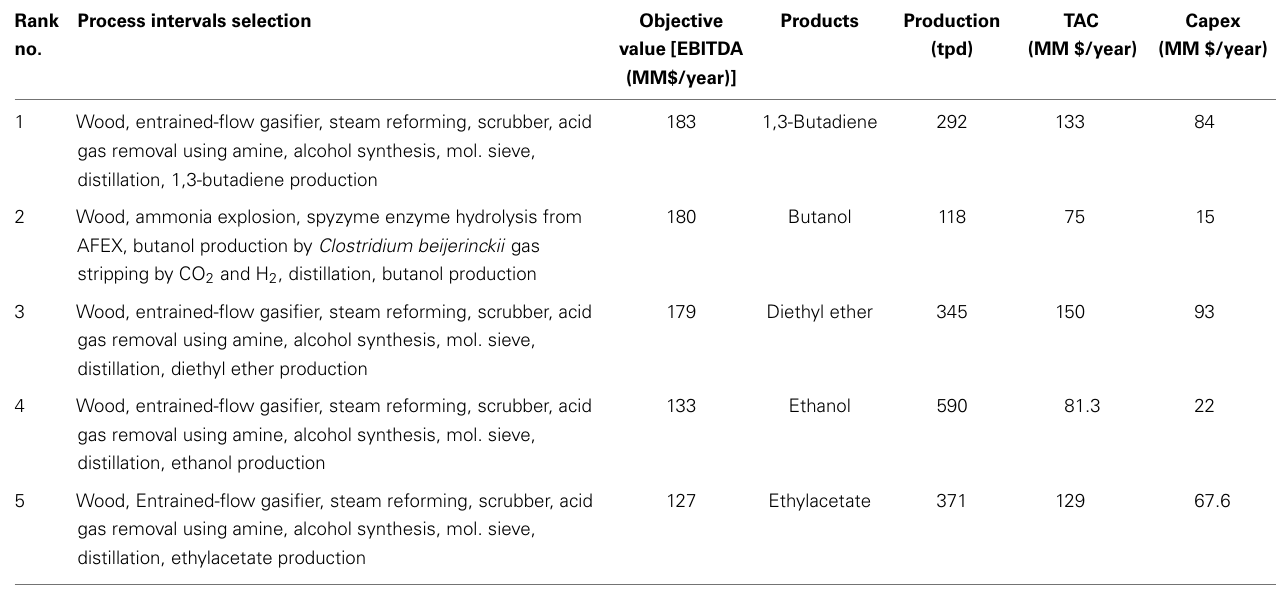
Table 10 |Top-five ranking of the optimal solutions using Model 3 ( + 30 to + 100%) for capital cost estimation (max EBITDA of producing ethanol derivatives) .